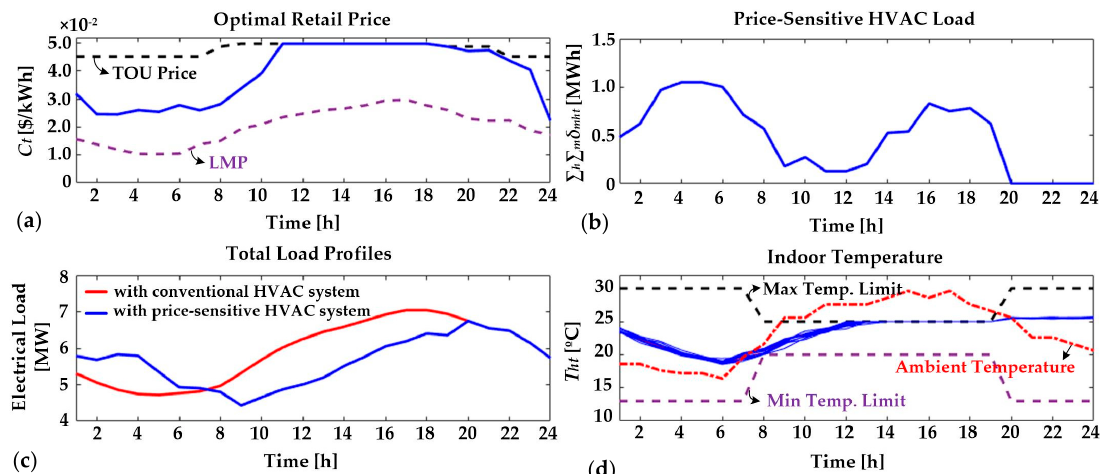
Figure 6. Optimal profiles for the proposed strategy considering peak load reduction with conventional load curve: ( a ) The optimal retail price, ( b ) total input power of the price-elastic HVAC units, ( c ) total load profiles, and ( d ) indoor temperature variations in 15 building rooms.